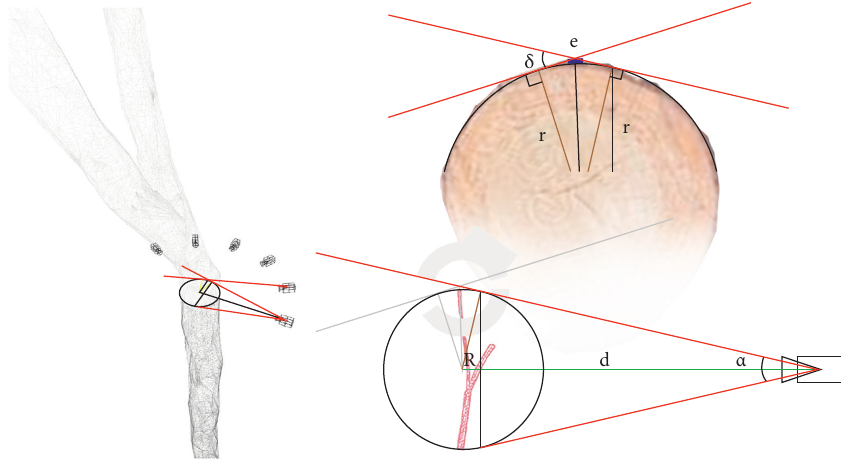
Figure 3: Parameter determination and error